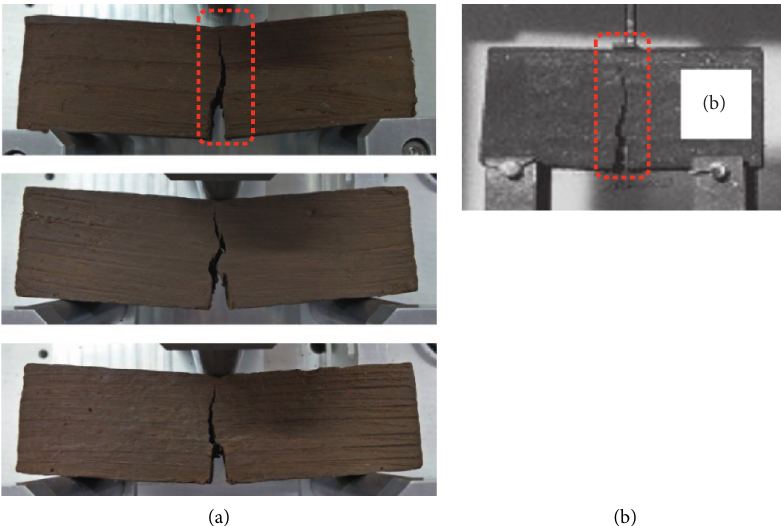
Figure 5: Crack propagation morphology in the group with offset ratio C ˆ 0. (a) Results of this experiment: C0-G1, C0-G2, and C0-G3 (from the top to the bottom); (b) result of crack propagation morphology in